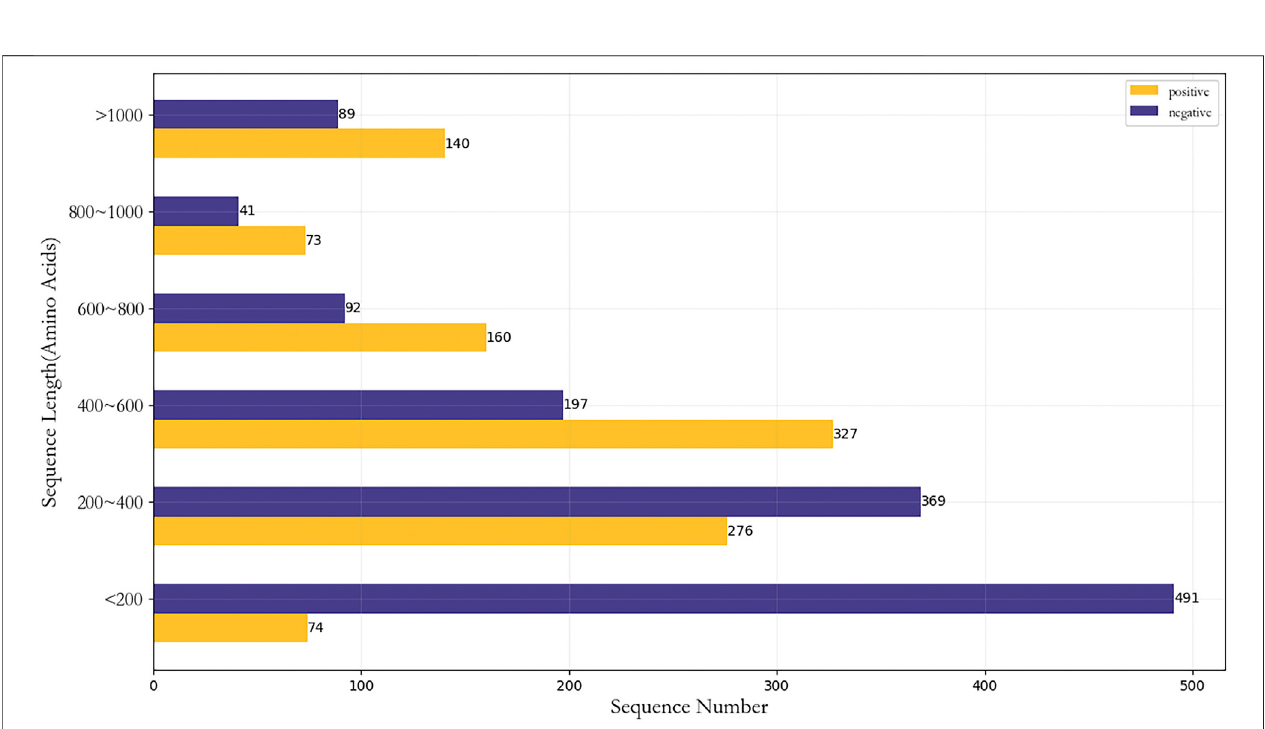
FIGURE1| FlowchartofDrugHybrid_BSmodel (A) Processthereferenceddataset (B) Threesinglefeaturerepresentationmethodswereusedtoextractfeatures (C) Combine three single feature representation methods and select the best hybrid feature (D) Use MRMD to remove redundant features and MRMD2.0 to obtain key features (E) FeaturesubsetswereusedtopredictpotentiallydruggableproteinsthroughtheoptimizedBagging-SVMmodel (F) Evaluatemodelpredictioneffectsbased on performance indicators.